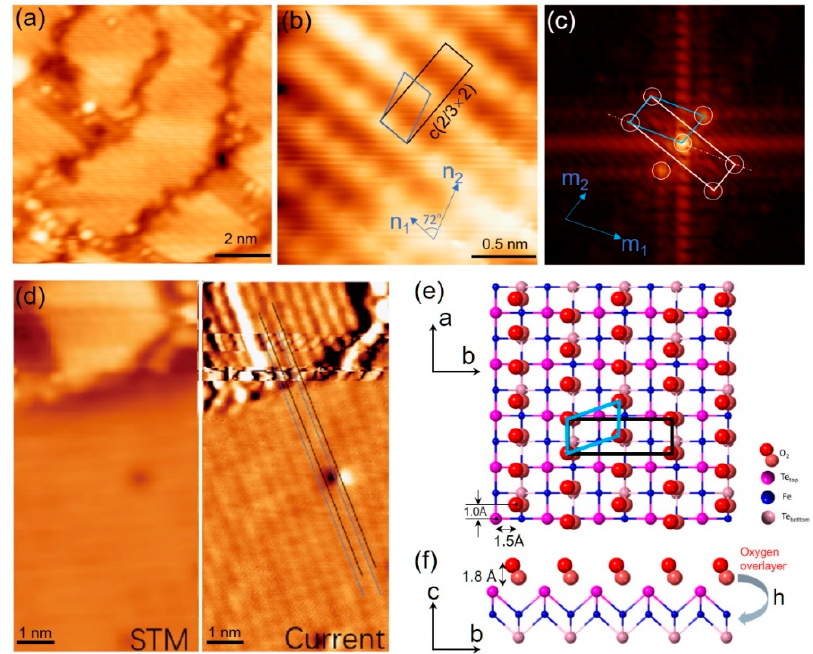
Figure 3. (Color online) ( a ) Small compacted FeTe : O 2 islands on 10UC FeTe. Dispersed clusters can be observed at domain boundaries. Scanning condition: sample bias V s = 1 V, tunneling current I t = 200 pA. ( b ) Atomically resolved STM images (2 nm × 2 nm) on FeTe : O 2 islands. Scanning condition: sample bias V s = 0.1 V, tunneling current I t = 200 pA. ( c ) The fast Fourier transform image of ( b ). White circles mark the reciprocal lattice. ( d ) STM topographic (left panel) and constant current (right panel) images (5 nm × 10 nm) of the 10UC FeTe films with one FeTe : O 2 island. The current image helps us to measure the adsorption geometrical configuration. Scanning condition: sample bias V s = 0.3 V, tunneling current I t = 300 pA. ( e , f ) Schematic diagrams of geometrical configuration of O 2 adsorption overlayer on FeTe: ( e ) top side and ( f ) side